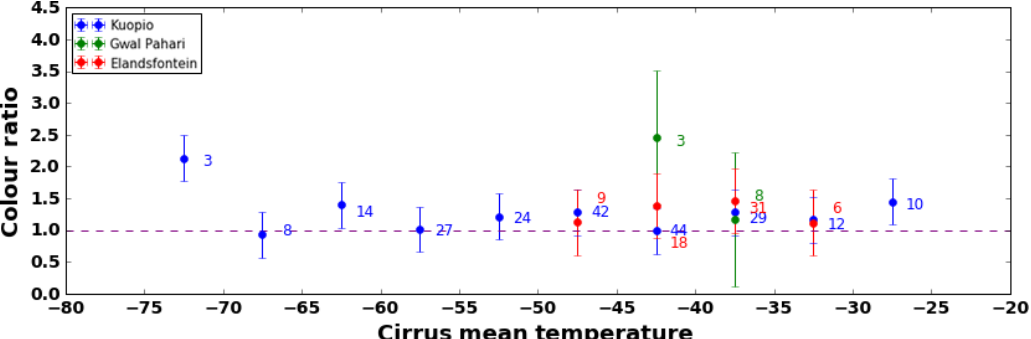
Figure 9. Dependencies of colour ratio (355 / 532) on 5 ◦ C intervals of mid-cirrus temperature. Numbers labelled indicate the number of cases per temperature bin.